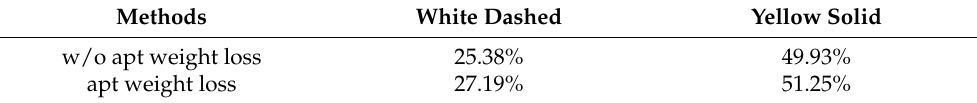
Table 4. Improvement of small proportion category by adaptive weighted cross-entropy. Methods White Dashed